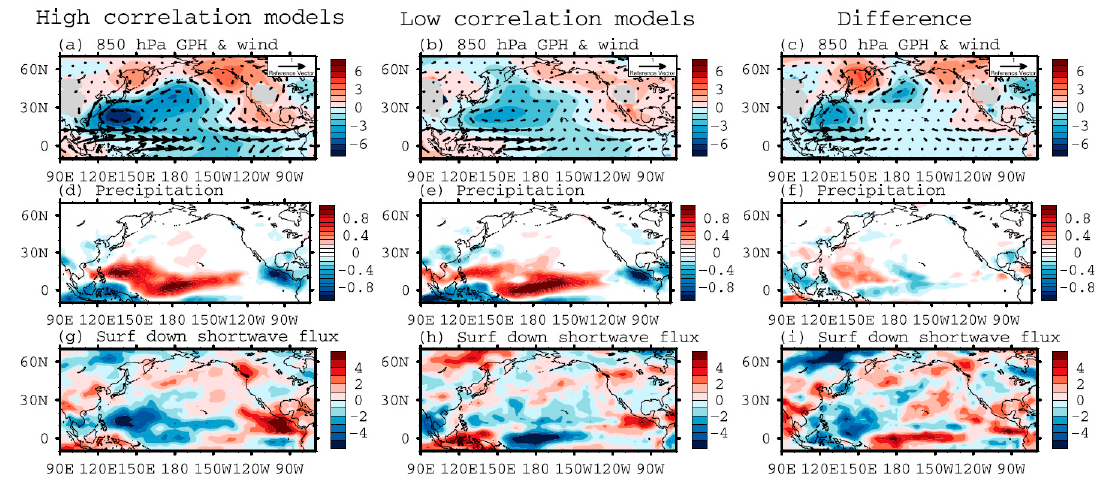
Figure 11. The regressed fields of ( a – c ) 850 hPa geopotential height (shaded; m) and wind (vector; m s − 1 ), ( d – f ) precipitation (mm day − 1 ), ( g – i ) surface downwelling shortwave flux (W m − 2 ) against PC2 time series. The left panel shows the MMM for the six models showing the best performance (high correlation), the center panel demonstrates the MMM for another six models with the worst performance, and the right panel shows the difference between the left and center panels.